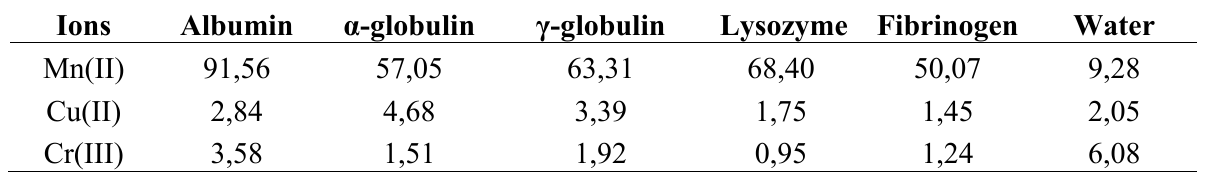
Table 2. The r values of the paramagnetic ions in solutions of albumin,  -globulin,  - 2 globulin, lysozyme, fibrinogen and